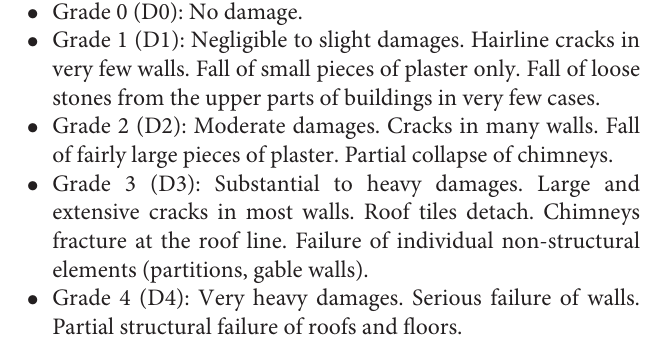
TABLE 1 | Damage probability matrix for buildings hit by the Sarpol-e-zahab earthquake: damage level vs. PGA. Damage Type PGA